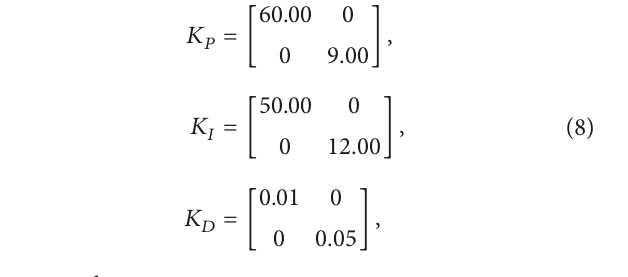
Figure 10 is the “Target_Motor” subsystem. The red dashed box contains the proportional, integral, and derivative terms of the PID controller. The green dashed box